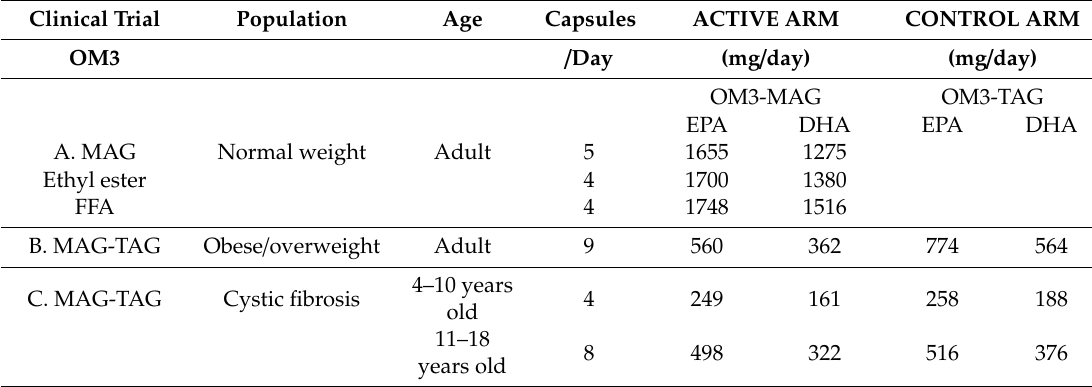
Table 1. Study groups and oil consumed per clinical